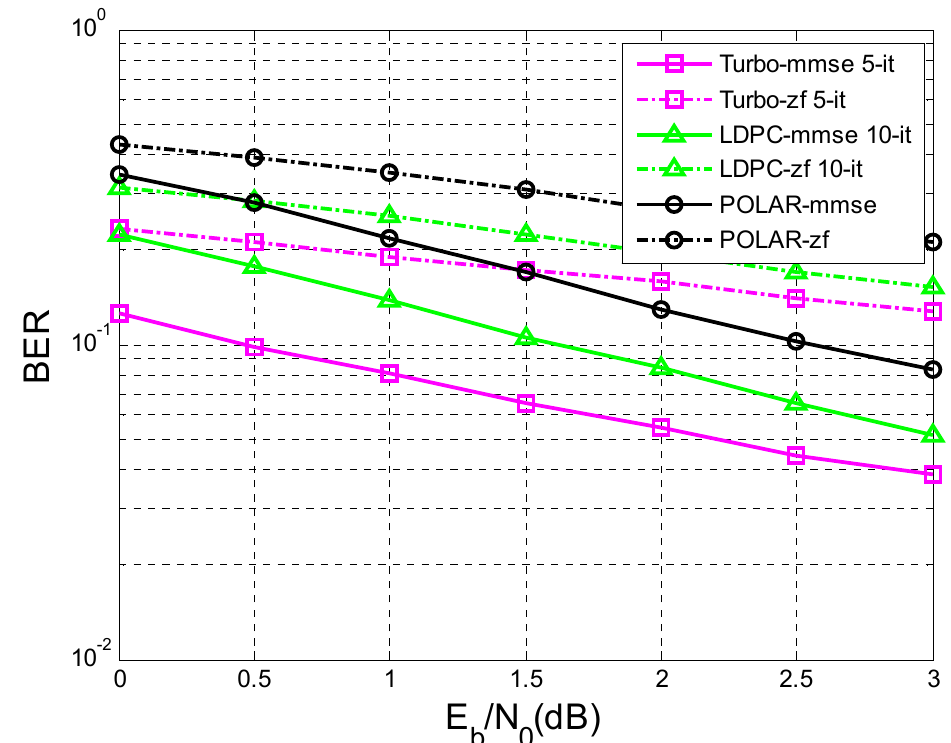
Figure 14. BER vs. SNR for different codes in the case of MMSE and ZF equalization applying LS estimation (K = 342 bits h = (0.18 0.85 0.32), N = 8).